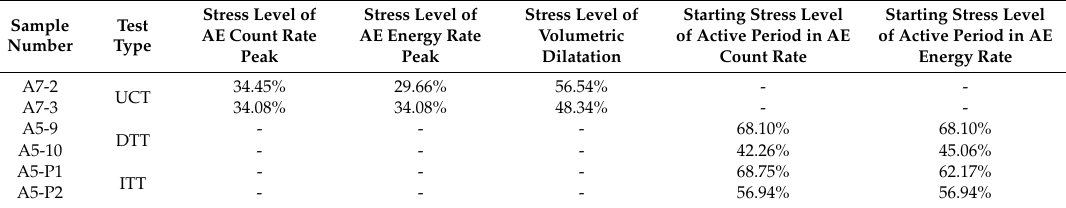
Table 2. First precursor point before failure according to the AE parameters under di ff erent loading